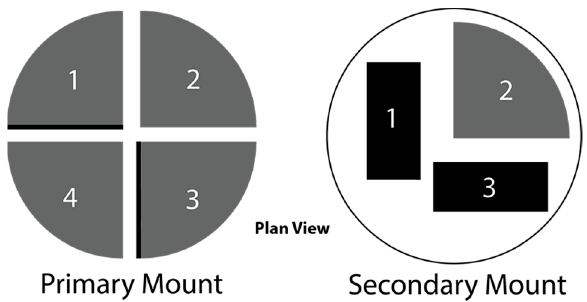
Figure 3. Mounting schematic displaying the basal surface of the two mounting stages. The primary grain mount was quartered, and three quarters were reoriented and made into a second mount to display one basal surface and two cross-sectional surfaces for analysis. Cross-sectional surfaces are indicated by the black grey bar in left pane of figure.